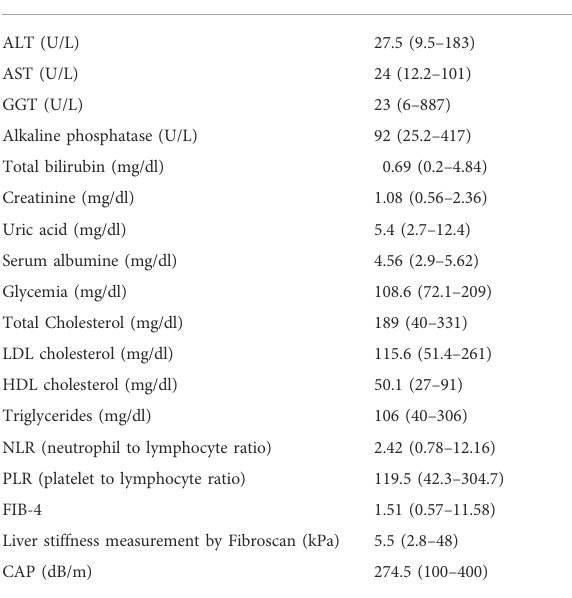
TABLE 1 Biochemical characteristics and noninvasive liver fi brosis assessment of the analysed cohort.